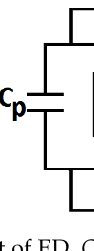
Figure 8. Equivalent electrical capacitance C p ( a ) and resistance R p ( b ) of hMCs, as a function of magnetic flux density B .